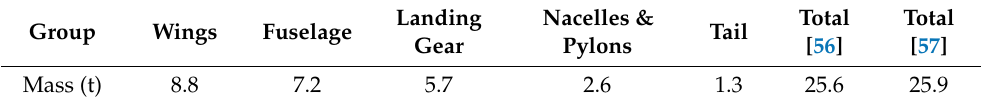
Table 6. Structural mass in a conventional A320 compiled using data from [56,57]. Group